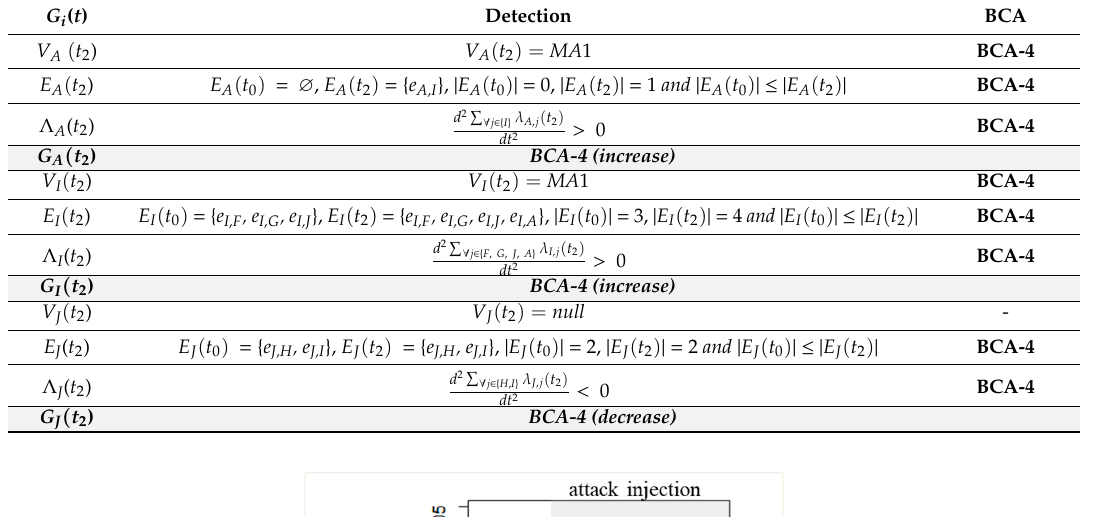
Figure 13. Iterative behavior of host B. Table 11. BCA-4 detection on host A , I and J at t 2 during a flooding attack. Table 10. BCA-2 detection on host B at t 1 during a password attack.